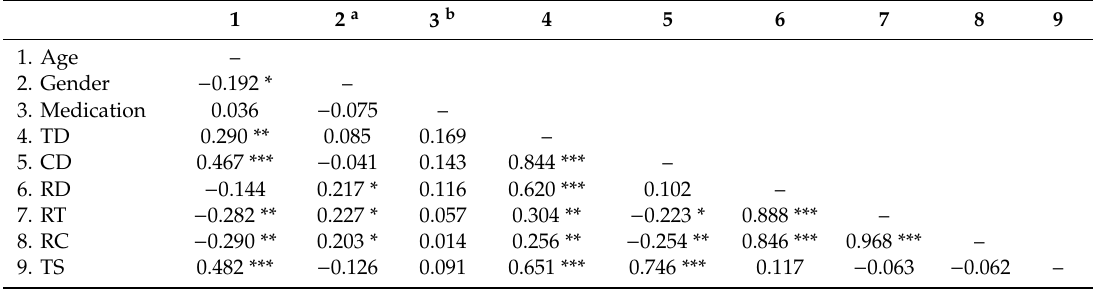
Table 2. Pearson correlation coe ffi cients for age, gender, medication, and FPT